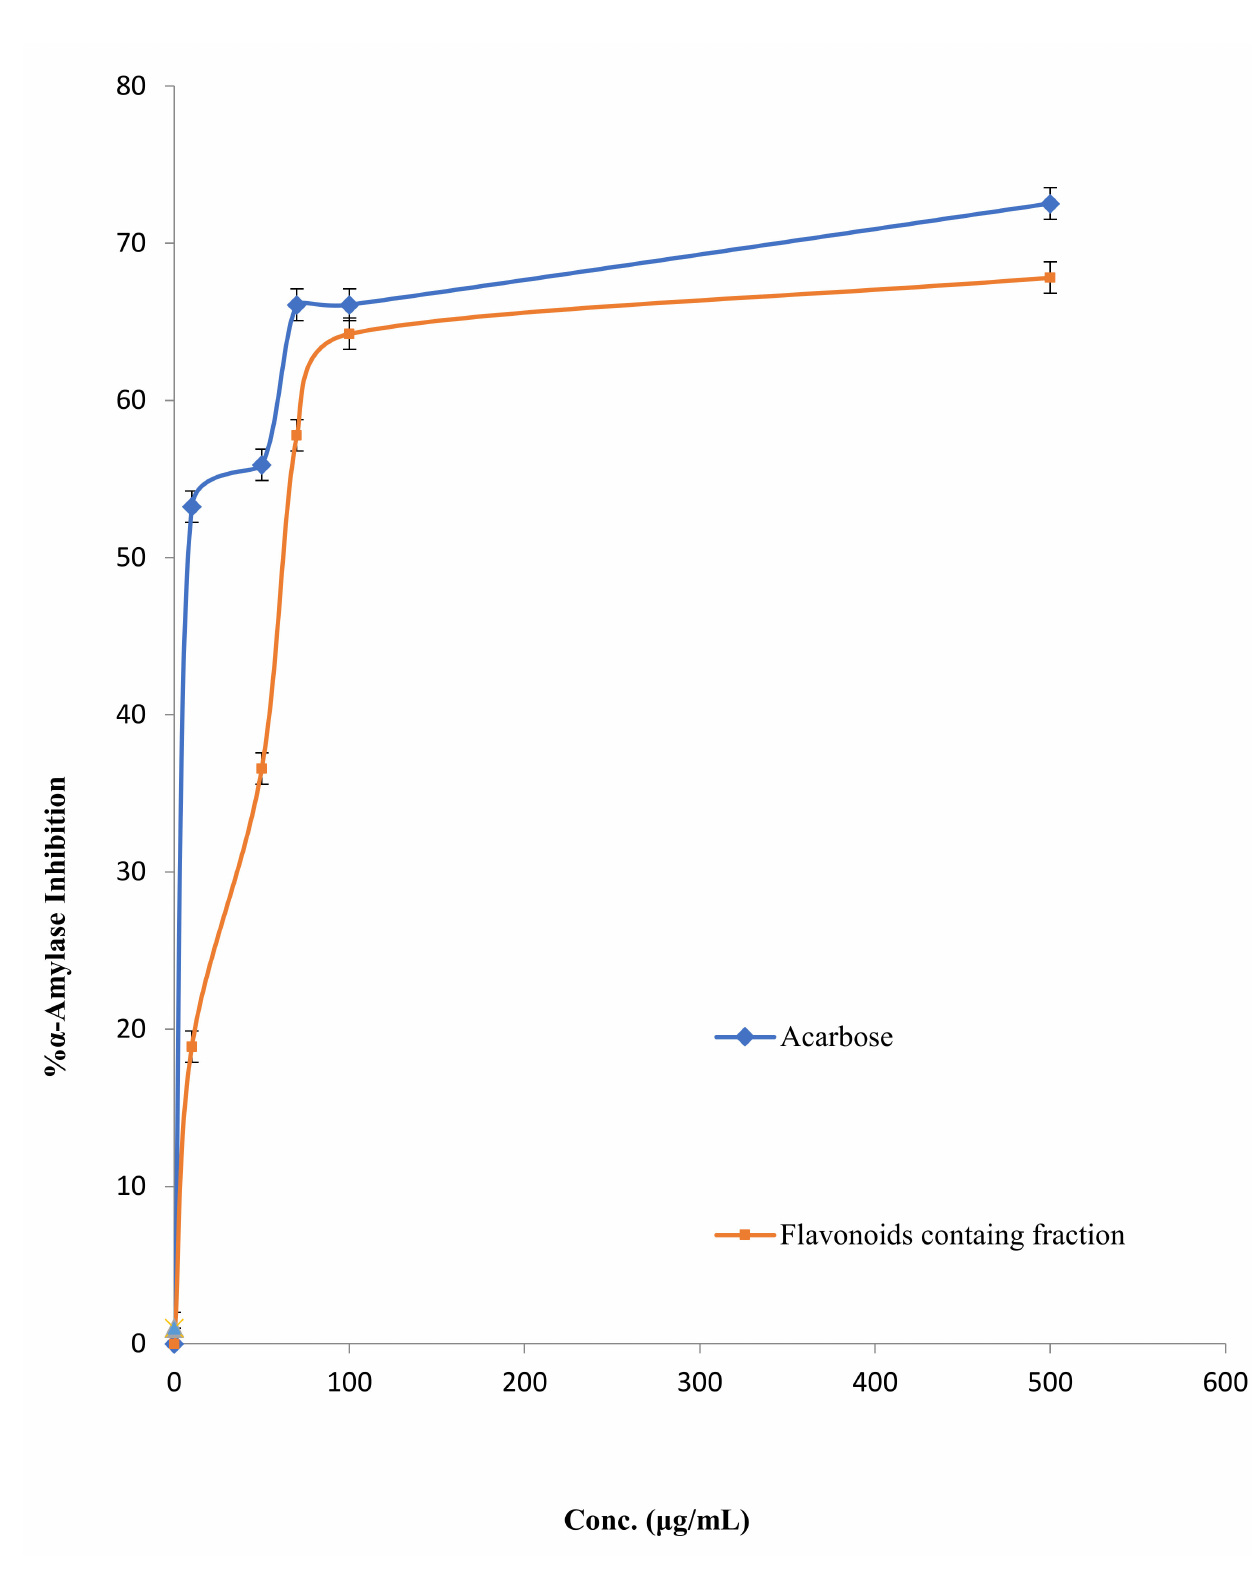
Figure 4. α -Amylase inhibitory activity of FFM and